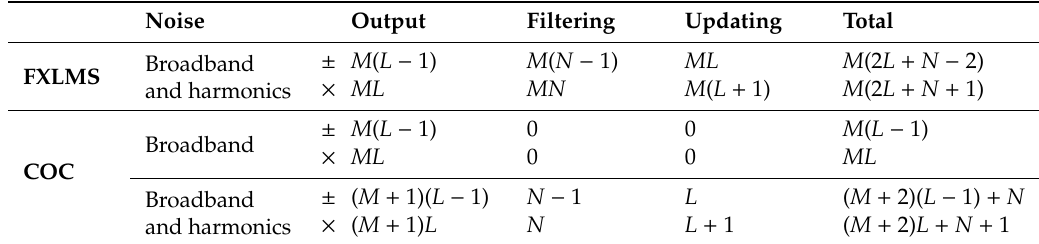
Table 1. Computational complexity